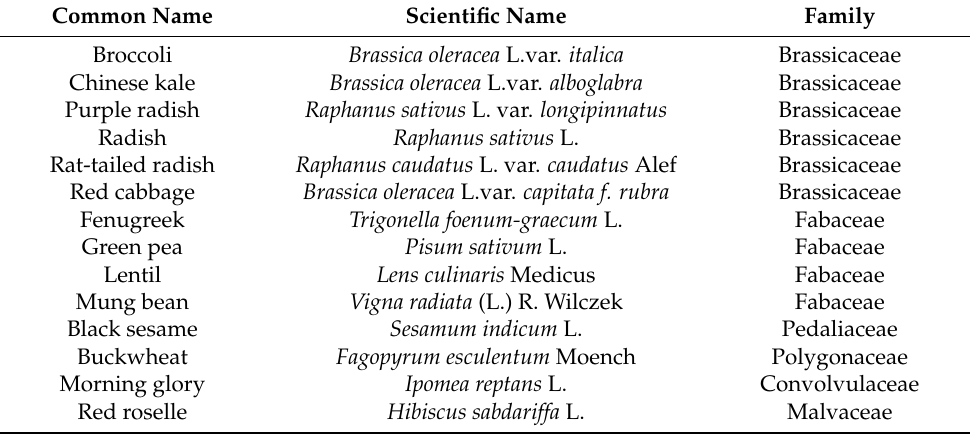
Table 1. Common names and scientific nomenclature of the studied